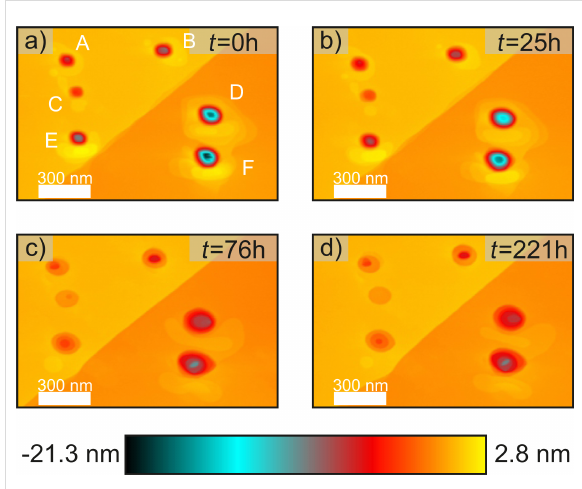
Figure 2: 1.5 μ m × 1.0 μ m sections showing the time evolution of artifi- cial defects and accumulations in three ranges of relative humidity. (a